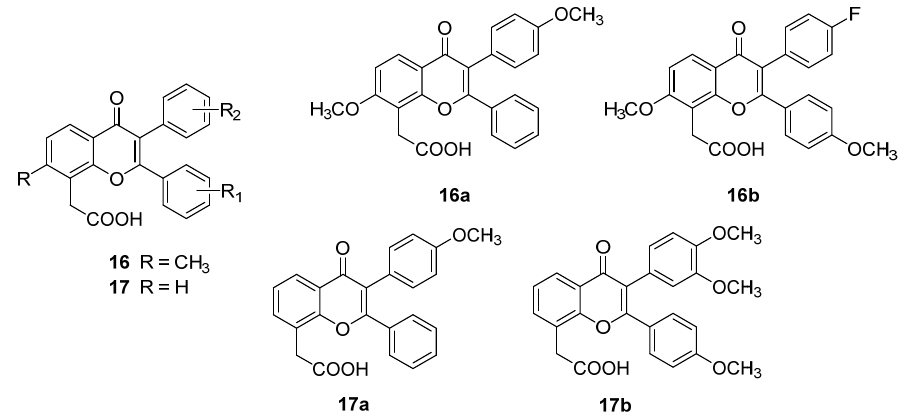
Figure 11. 2,3-Diarylchromones as FAA